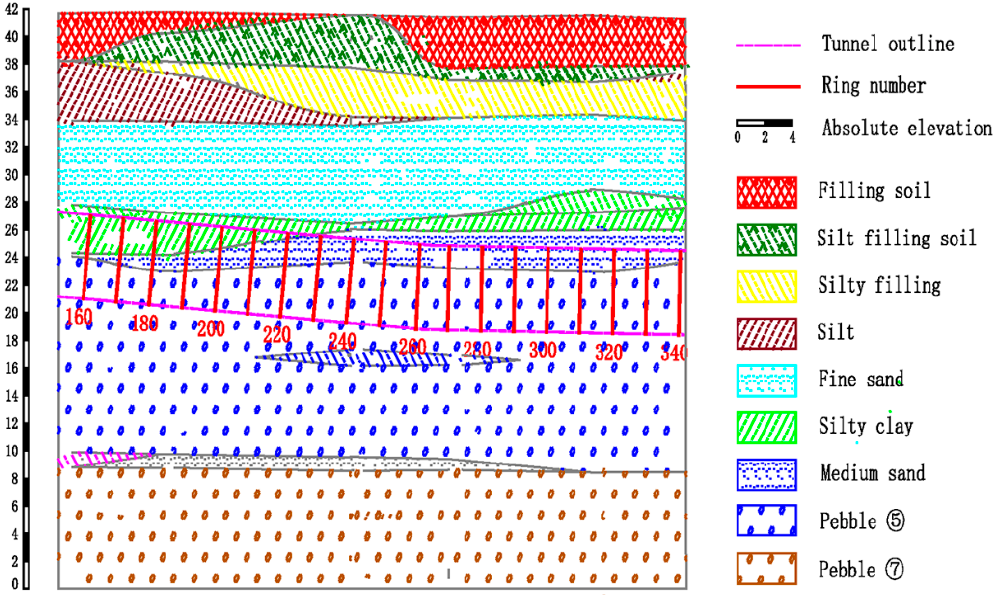
Figure 8. Sections of excavated strata in the study area.